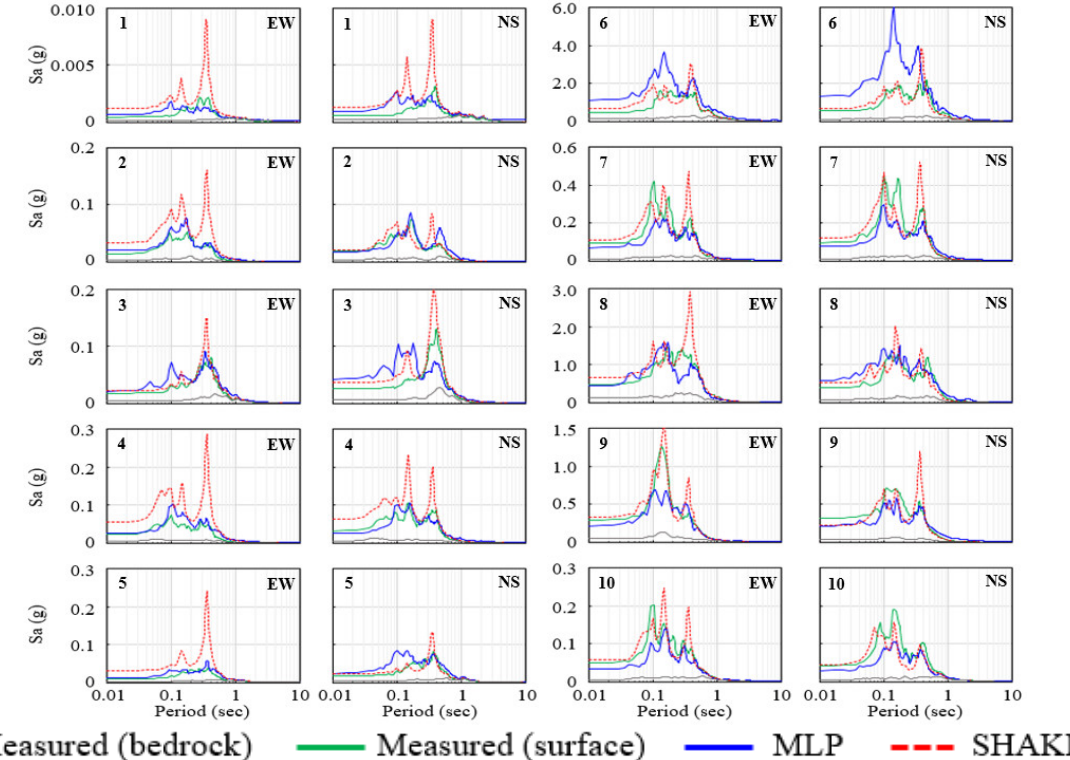
Figure 10. Measured, predicted, and computed response spectra at IBRH13 for east–west and north–south directions.